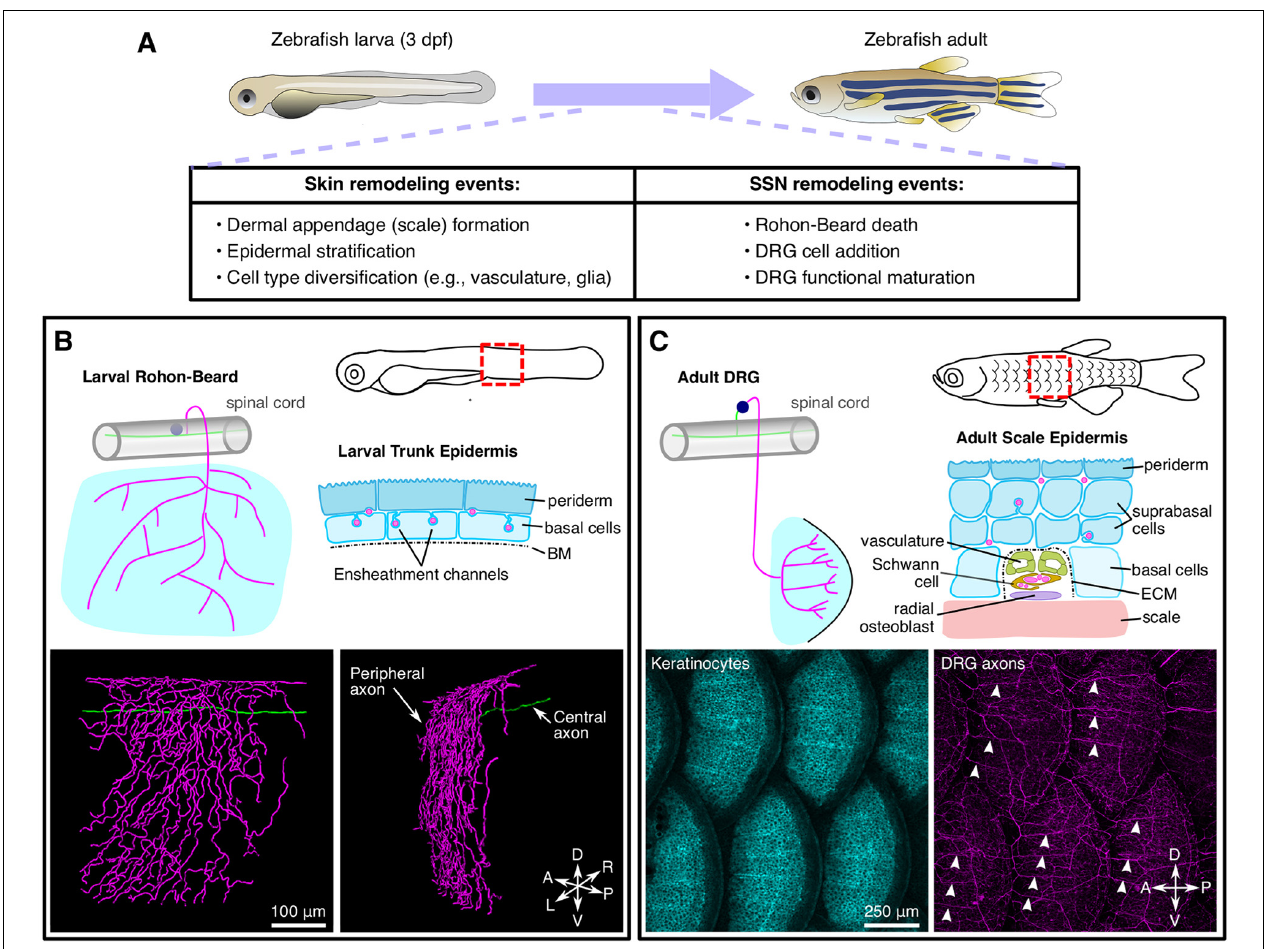
FIGURE 3 | Anatomy and remodeling of zebrafish SSNs and skin. (A) Overview of changes to the skin and SSNs that occur during the larval-to-adult transition. (B) Anatomy of Rohon-Beard (RB) neurons in larval zebrafish. Top, illustration of the typical morphology of larval RB neurons along the trunk (left) and a transverse section through the epidermis (right). Bottom, partial reconstruction of a larval RB. Note that the peripheral axon predominantly arborizes along the dorsal-ventral (DV) axis. (C) Anatomy of dorsal root ganglion (DRG) neurons in adult zebrafish. Top, illustration of the typical morphology of DRG neurons innervating the adult scale epidermis along the trunk (left) and a transverse cross section through the epidermis surrounding a radial DRG axon bundle (right). Bottom, maximum intensity projections showing keratinocytes [labeled by Tg(krt4:GFP) ] and DRG peripheral axons [labeled by Tg(p2rx3a:lexa;lexaop:mCherry) ]. Note that the radial nerve bundles (arrowheads) orient anterior-posterior (AP) along the scale surface. Micrographs in (C) adapted from Rasmussen et al. (2018), with permission from